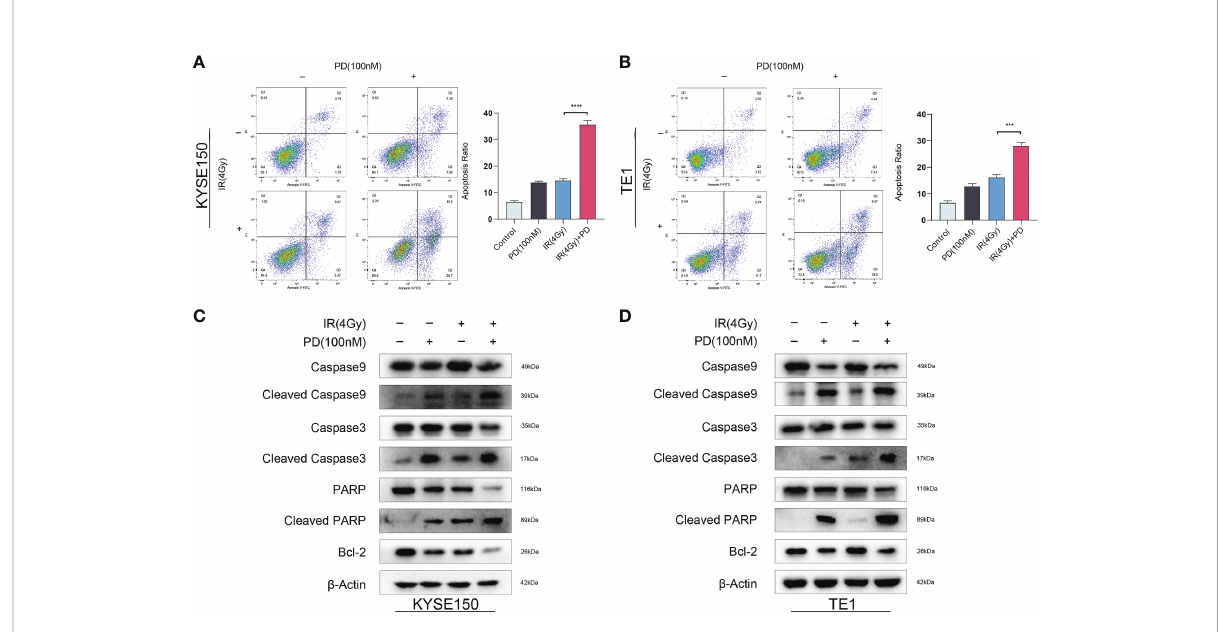
FIGURE 4 Combination therapy of PD and irradiation induces cell apoptosis. (A, B) The combination therapy of PD and irradiation increases the apoptosis ratio in ESCC cells. (C, D) The protein level of apoptosis-related altered with combination therapy. ***P < 0.001, ****P < 0.0001.